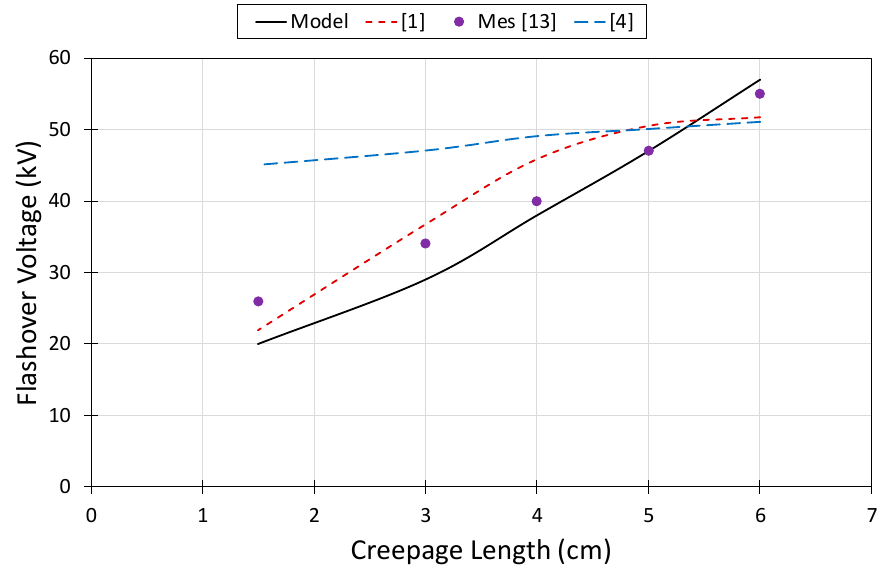
Figure 9. Comparison between calculated and measured flashover voltage versus creepage distance in air at atmospheric pressure for insulator 1.